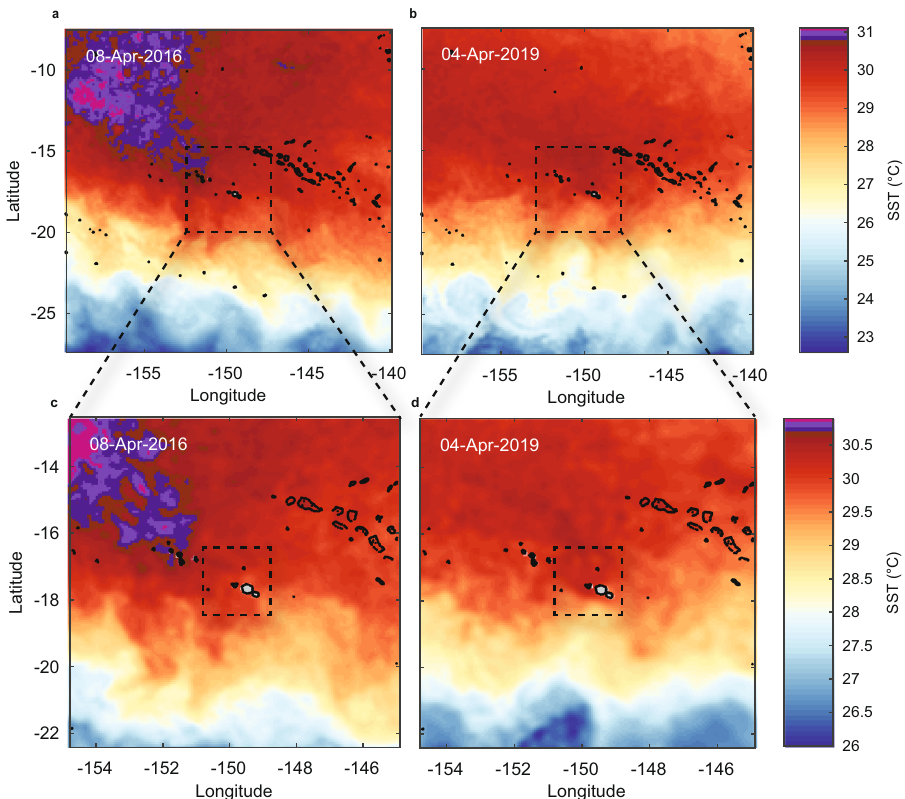
Fig. 2 | Regional sea-surface temperature (SST) variability during the peak of the2016and2019surfacemarineheatwavesaroundMooreasuggestedhotter conditions during 2016. Panels show SST over a , b 20°×20° and c , d 10°×10° during2016and2019,respectively,focusingonthedateofpeakSSTobservedover